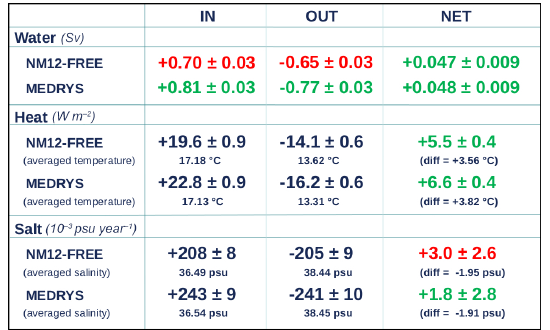
Figure 15. Average flow, heat and salt transport of the inflow and the outflow through the Strait of Gibraltar at 5.5 ◦ W between 1992 and 2013 for NM12-FREE and MEDRYS. The uncertainty corre- sponds to the annual standard deviation. For heat and salt transport, the associated mean temperature and salinity in the layer are spec- ified. The green color represents values consistent with literature or/and reference products and the red color those that are not con-